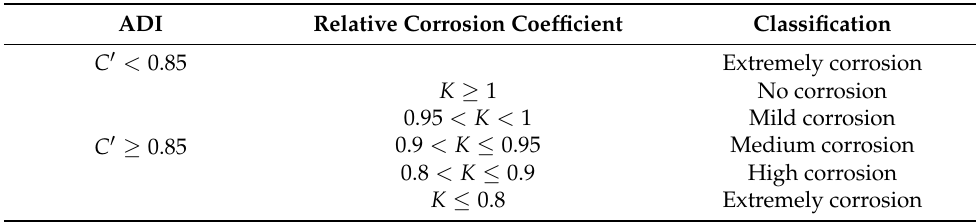
Table 4. The evaluation classification of the relative corrosion